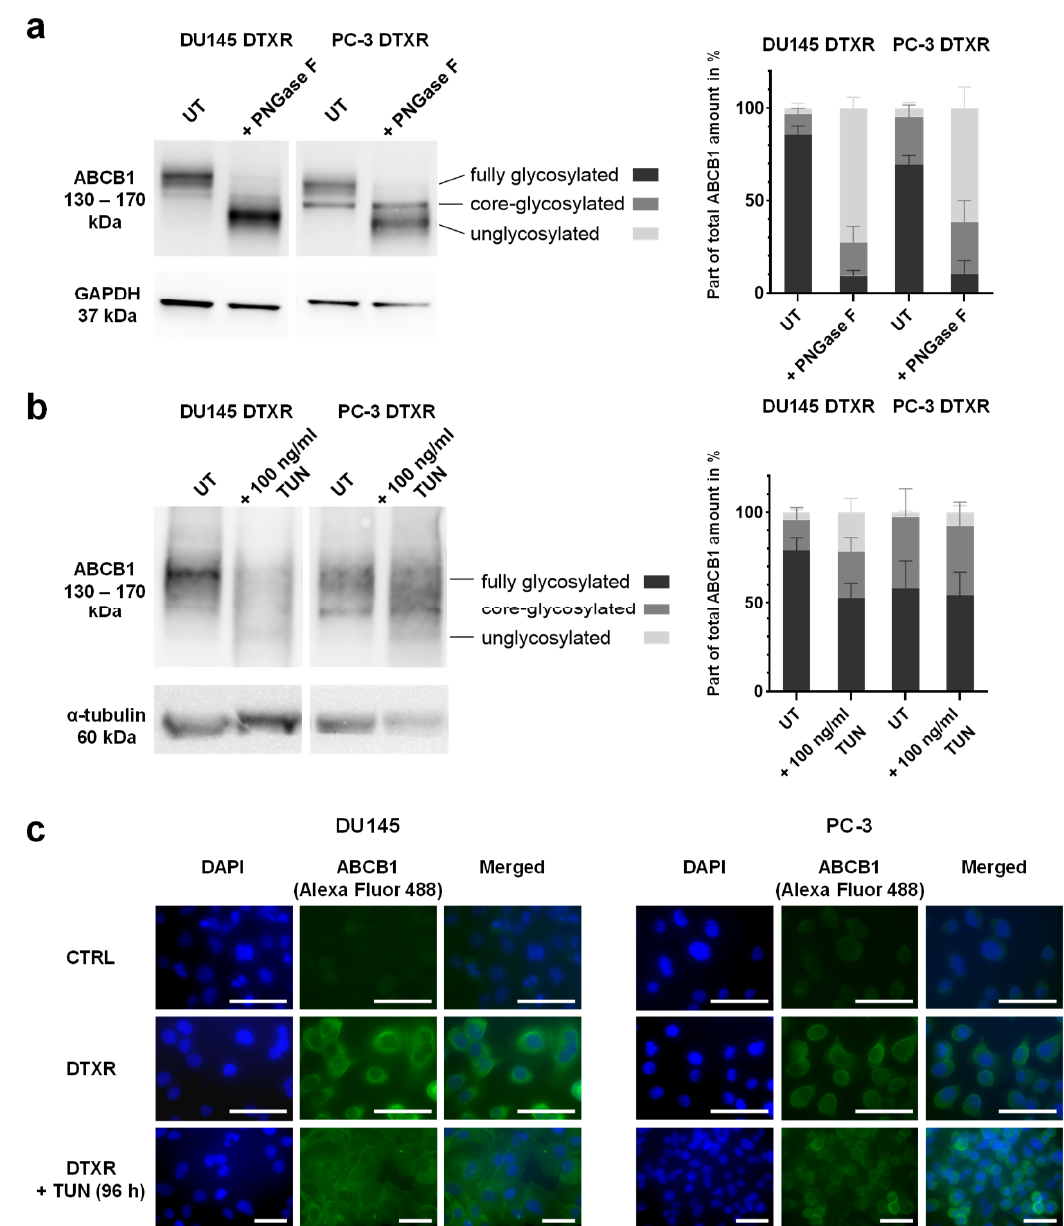
Figure 5. Influence of PNGase F digestion and tunicamycin treatment on the glycosylation status and localization of ABCB1 protein in DU145 and PC-3 DTXR cells. ( a ) Protein lysates of DU145 and PC-3 DTXR cells were treated with PNGase F for 2 h and compared to untreated protein lysates (UT). An exemplary Western blot for the detection of ABCB1 protein with GAPDH as reference protein is shown. ( b ) DU145 and PC-3 DTXR cells were pre-treated with 100 ng/mL tunicamycin (TUN) for 96 h and compared to untreated cells (UT). An exemplary Western blot for detecting ABCB1 protein with α -tubulin as reference protein is shown. ( a , b ) The protein bands were analyzed densitometrically and then normalized to the respective reference protein. The different glycosylation statuses are depicted as part of the total ABCB1 amount in %. ( c ) Immunofluorescence staining of ABCB1 in DU145 and PC-3 CTRL cells as well as DTXR cells with or without pre-treatment with 100 ng/mL tunicamycin (TUN) for 96 h. Cell nuclei were visualized with DAPI (blue), ABCB1 was detected using an anti-ABCB1 antibody and an Alexa Fluor 488-conjugated secondary antibody (green) and then the images were merged (scale bar 40 µm). Exemplary images and data, which are depicted as mean ± SD, are taken from four to five independent biological replicates.